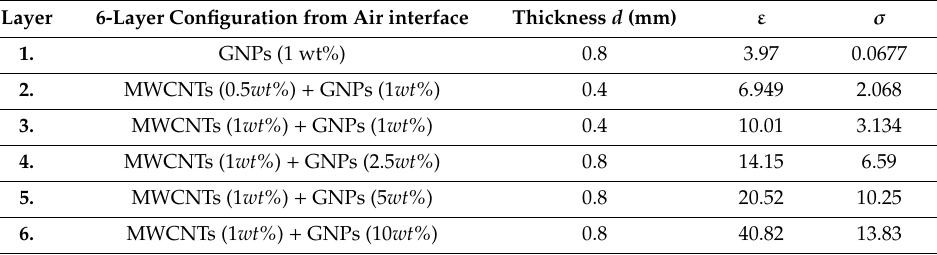
Figure 17. ( a ) Measured and computed ( a ) Reflection coefficient (𝑆 11 ) ( b ) Absorption for 6-layer multilayer absorber. Table 4. EM (electromagnetic) properties of the constituent layers for 6-layer